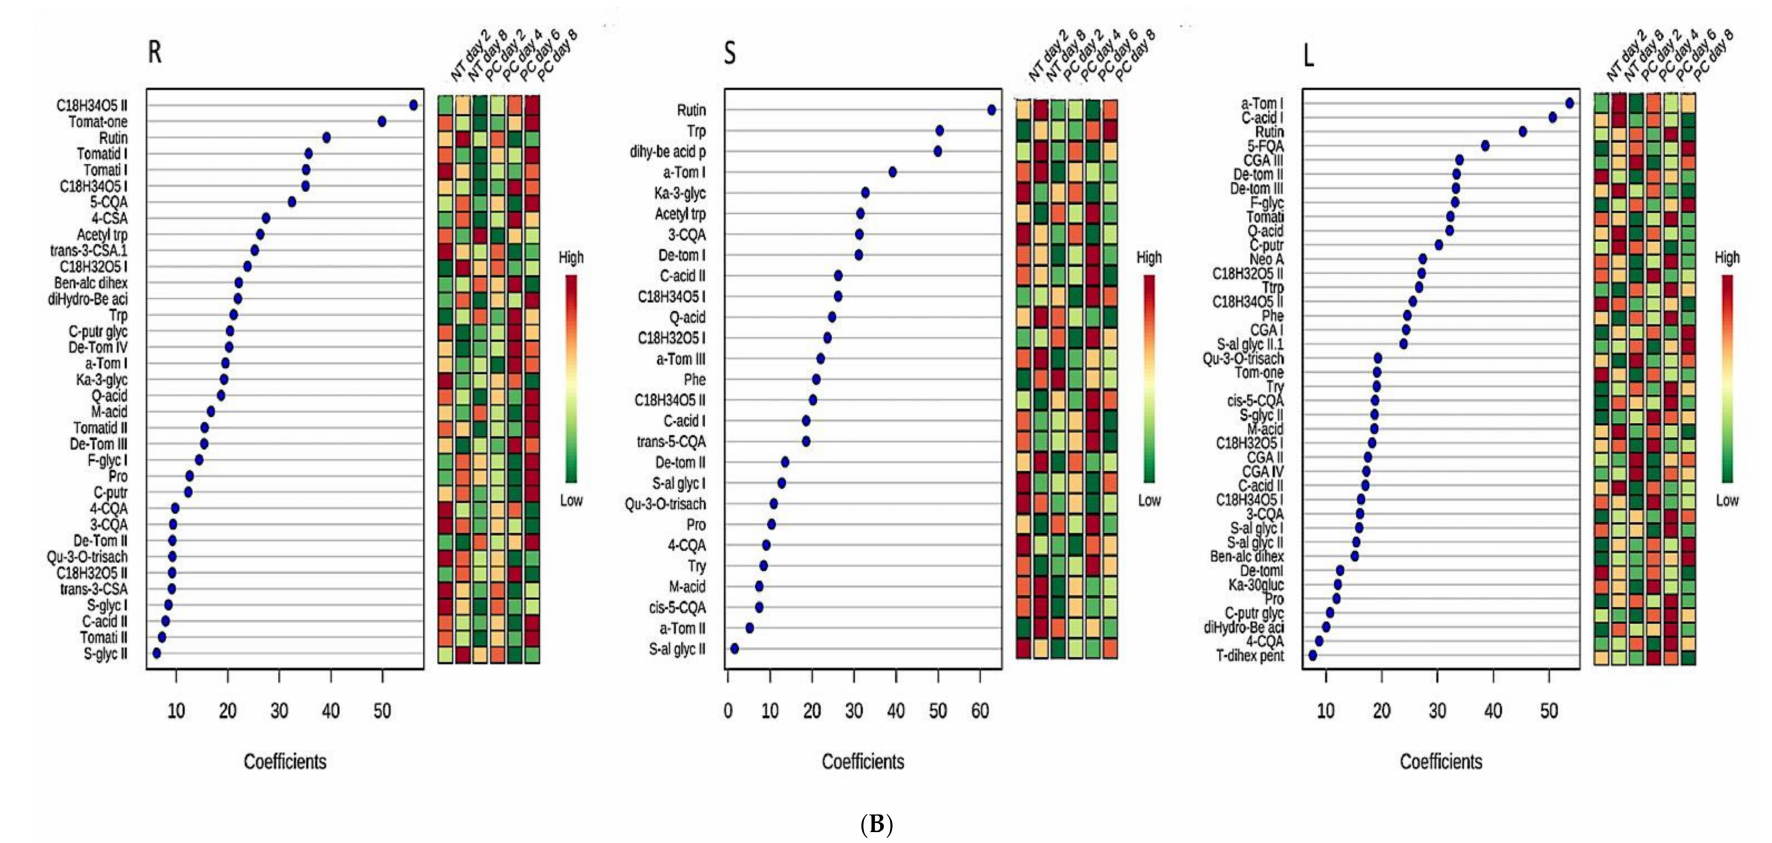
Figure 6. ( A ) Coefficient scores derived from the partial least squares discriminant analysis (PLS-DA) displaying discriminant features. Shown are annotated metabolites in primed- unchallenged ( Paenibacillus alvei T22) and primed-challenged ( Phytophthora capsici , PC) plant tissues for root (R), stem (S) and leaf (L) tissues. Selected metabolites (coefficient scores ≥ 2) from primed-unchallenged plants (NT days 2 and 8) were compared to those in primed-challenged plants at the given time point (PC—2, 4, 6, 8 d.p.i.). The abbreviated names of the annotated metabolites are listed in Table S6. ( B ) Coefficient scores derived from the partial least squares discriminant analysis (PLS-DA) displaying discriminant features. Shown are annotated metabolites in primed-unchallenged ( Pseudomonas fluorescens N04) and primed-challenged ( Phytophthora capsici , PC) plant tissues for root (R), stem (S) and leaf (L) tissues. Selected metabolites (coefficient scores ≥ 2) from primed-unchallenged plants (NT days 2 and 8) were compared to those in primed-challenged plants at the given time point (PC—2, 4, 6, 8 d.p.i.). The abbreviated names of the annotated metabolites are listed in Table